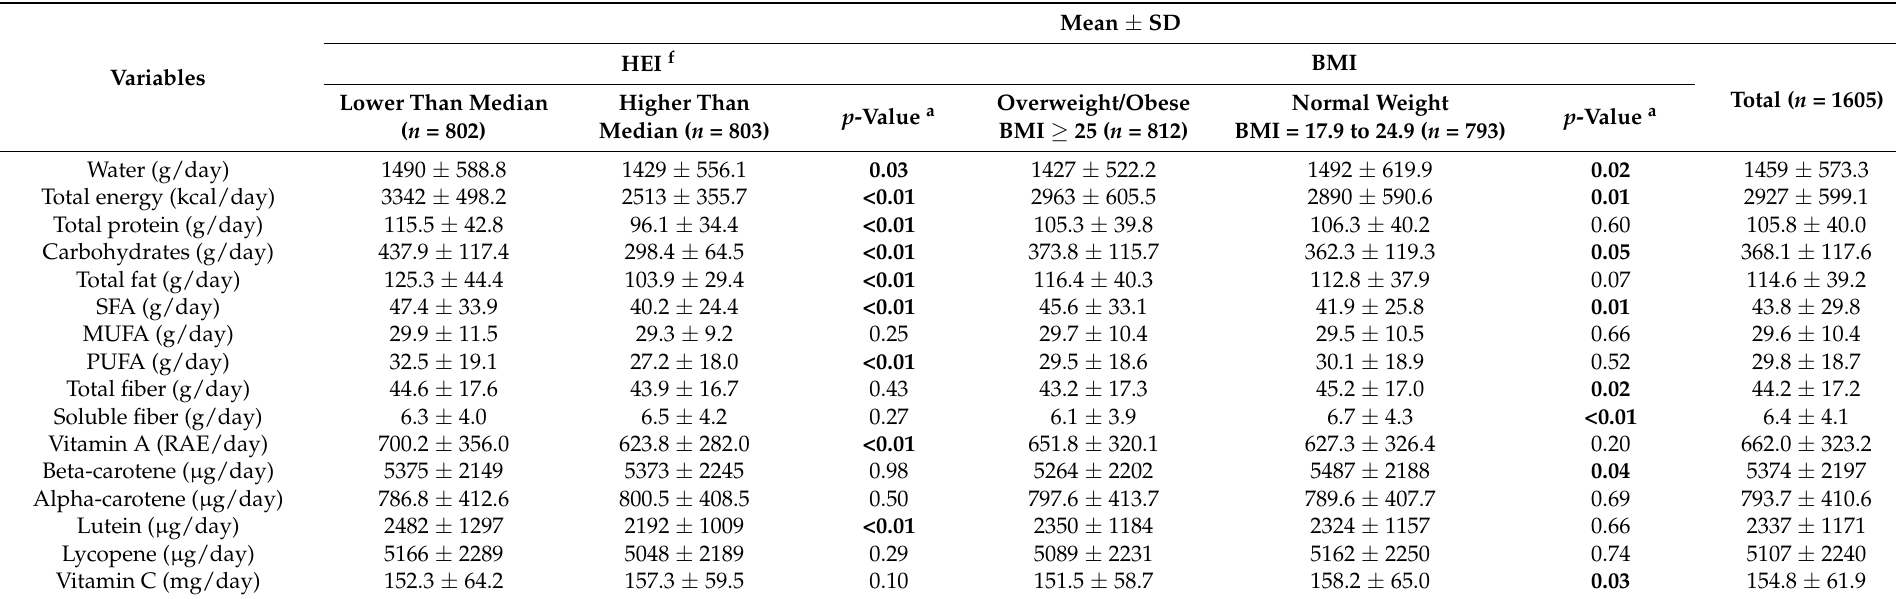
Table 2. Comparison (mean ± SD) of the macro-/micronutrient intakes of the participants based on HEI and BMI